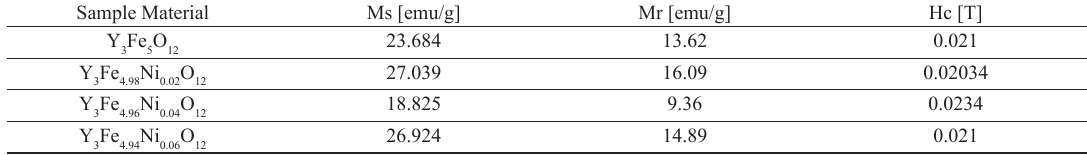
Table 3. Magnetic Saturarion (Ms), Magnetic Remenance (Mr), and Coercivity (Hc) from Hysteresis Loop. Sample